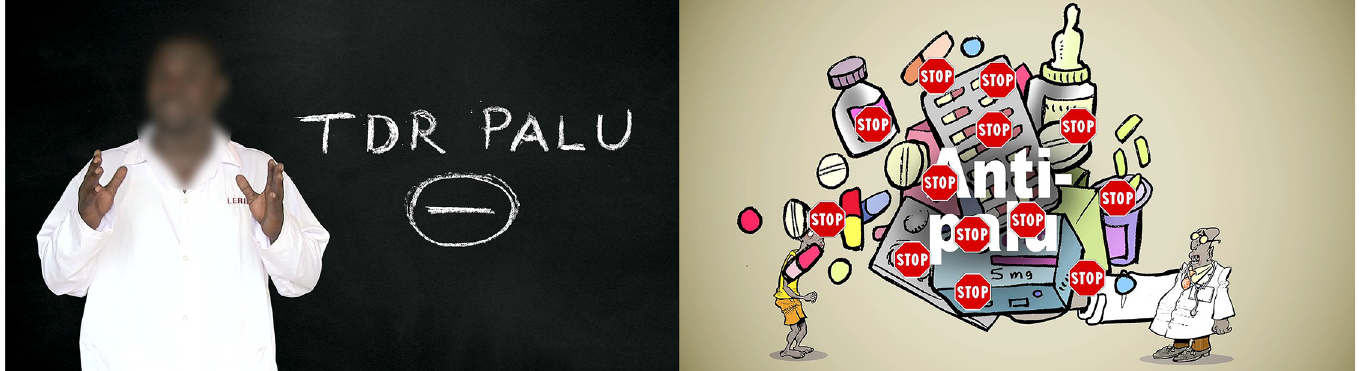
Fig 5. Visual elements of the dramatization and animation